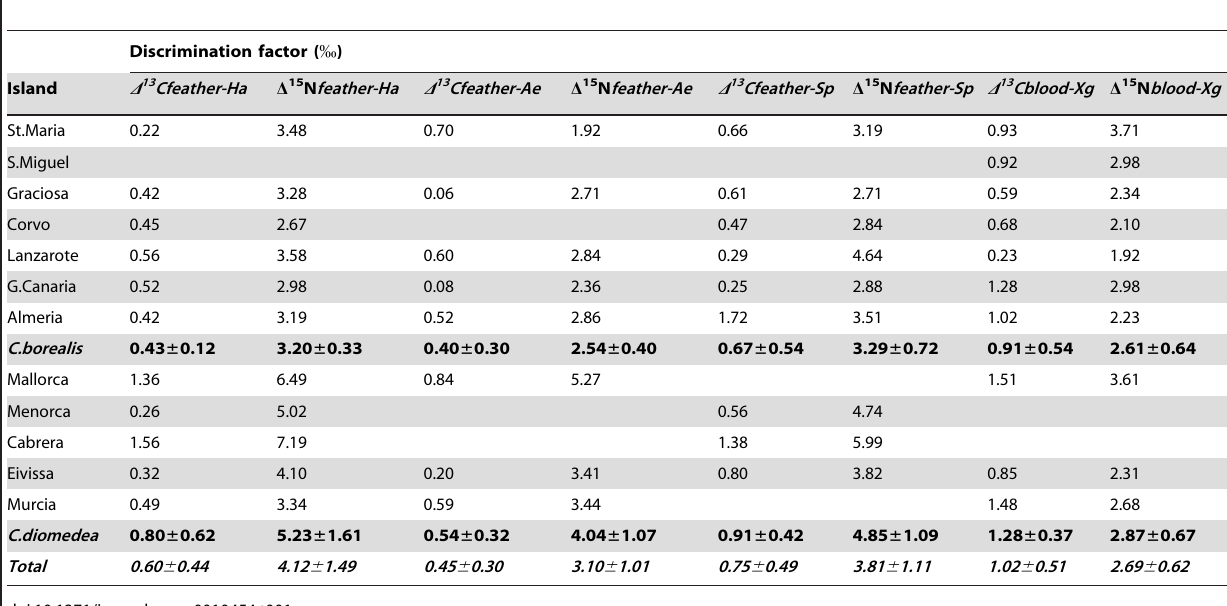
Table 1. Estimates of d 13 C d 15 N discrimination factors (Mean difference 6 Standard deviation) between the host resource and the ectoparasite tissue for each ectoparasite species and breeding locality.